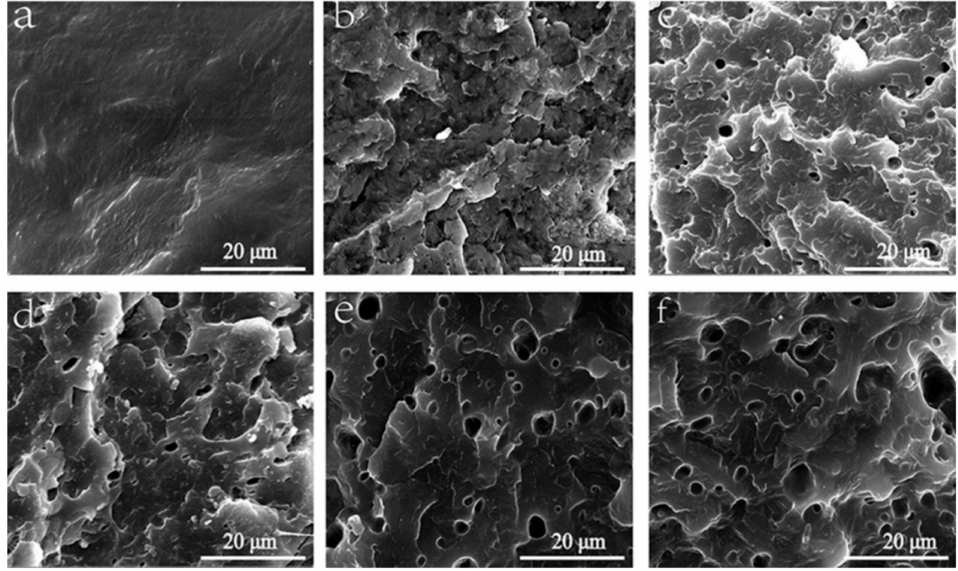
Figure 3. SEM images of the ( a ) POM, ( b ) 1P-A-M, ( c ) 2P-A-M, ( d ) 3P-A-M, ( e ) 4P-A-M, and ( f )